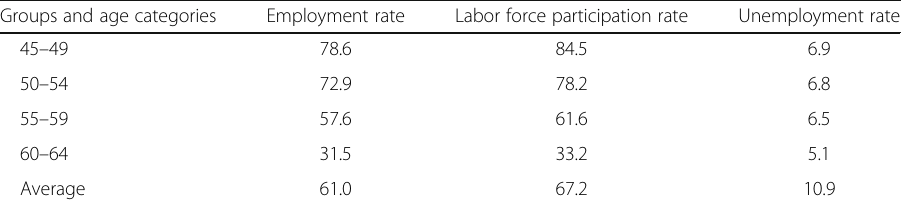
Table 5 Labor market performance variables, averages per group of countries and age category, 2000 – 2014